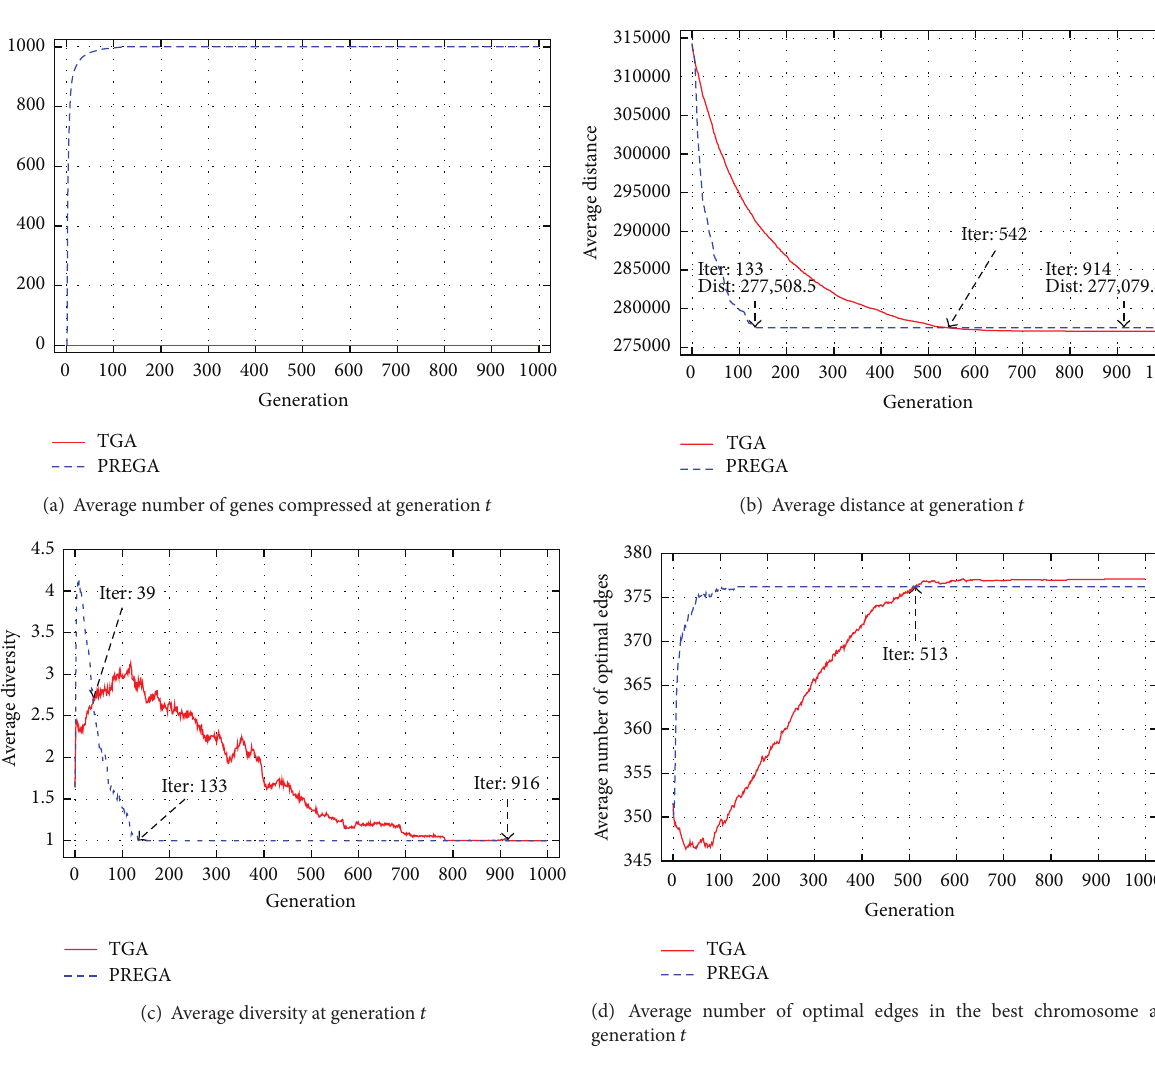
Figure 4: Example illustrating the performance of GA and PREGA for solving the benchmark